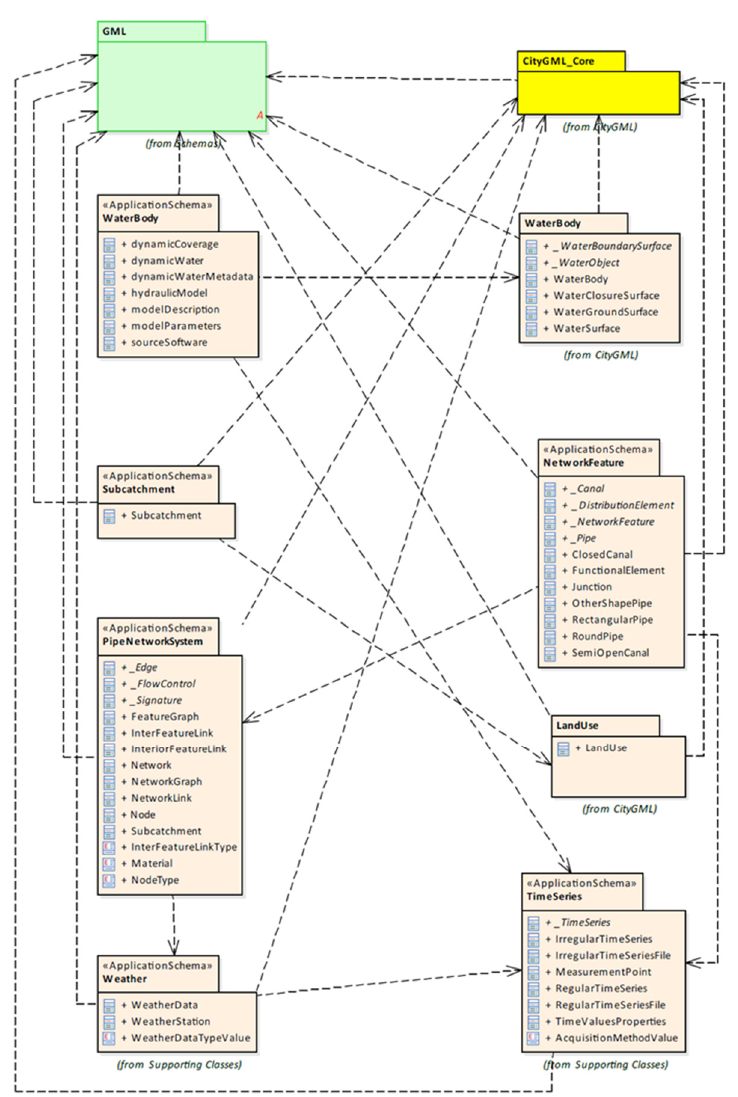
Figure 2. UML (Unified Modeling Language) model module structure diagram of the CTWLADE (City Waterlogging Application Domain